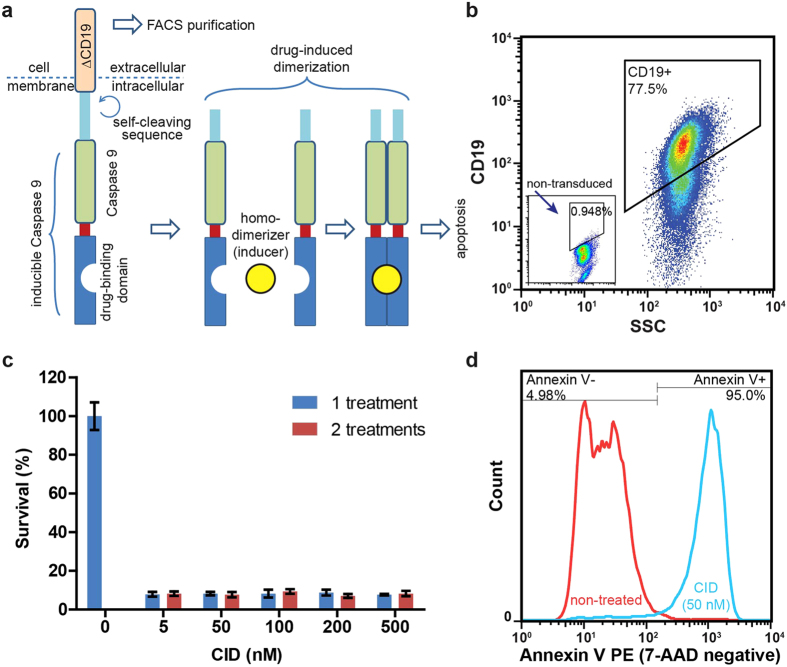
Establishment of suicide gene-engineered stromal cells.(a) The expressed protein from iCasp-ΔCD19 construct contains a CD19 cross-membrane domain for cell purification, and a self-cleavable inducible Caspase 9 (iCasp) domain. Dimerization of Caspase 9 will initiate cell apoptosis when the whole protein construct is dimerized by a homodimerizer at the drug-binding domain. (b) Flow cytometric analysis showed over 77.5% of the transduced CAF cells are positive for CD19 >5 passages after FACS purification. (c) The survival fraction of CAF-iCasp cells are uniformly low (<10%) across a wide range of CID homodimerizer treatment after one (24-hour) or two (48-hour) treatment doses. (d) Apoptosis analysis by Annexin V and 7-AAD co-staining shows over 95% of CAF-iCasp undergo apoptosis within 24  hours, after one dose of 50 nM CID treatment.